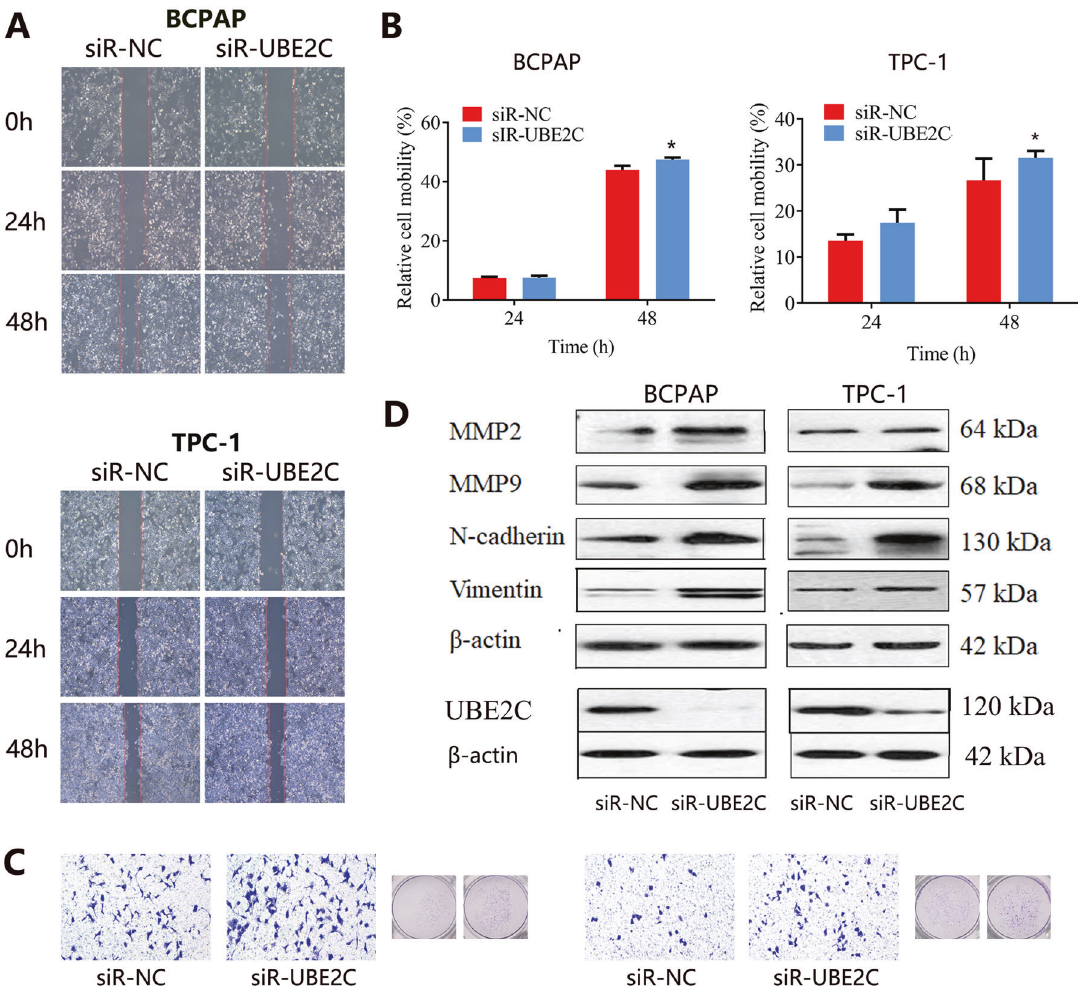
Fig. 6 Migration and invasion analyses of THCA cell lines with UBE2C knockdown. A Migration ability assessment by wound-healing assay. B Quantity analysis on cell mobility. C Invasion ability assessment by transwell invasion assay. D Western blot analysis on migration-related proteins. UBE2C ubiquitin-conjugating enzyme E2 C, THCA thyroid